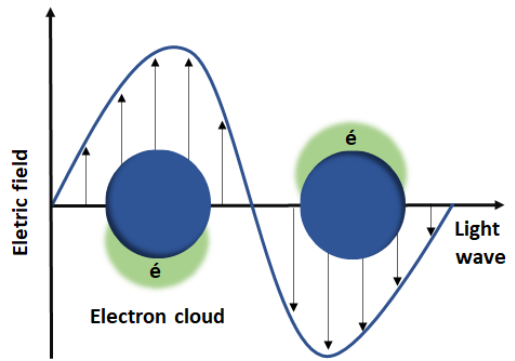
Figure 8. Surface Plasmon Resonance of gold nanoparticles.